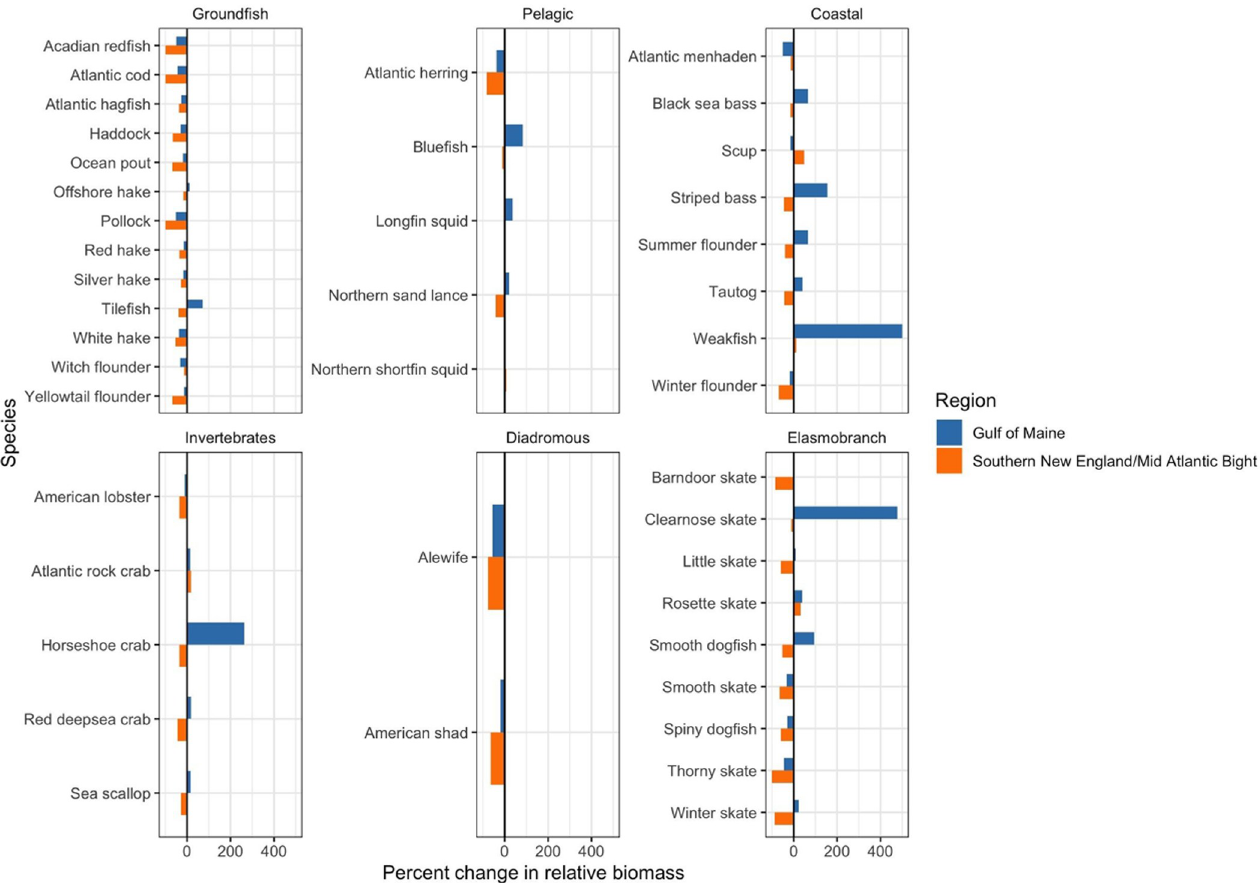
Fig 7. Fall regional projected percent changes in relative biomass by species functional group. Projected species relative biomass changes given the mean CMIP5 RCP 8.5 climate model ensemble projected sea surface temperatures. Positive percent increases were capped to 500% for weakfish to facilitate visualizing and comparing changes across species and climate model ensemble projected sea surface temperature